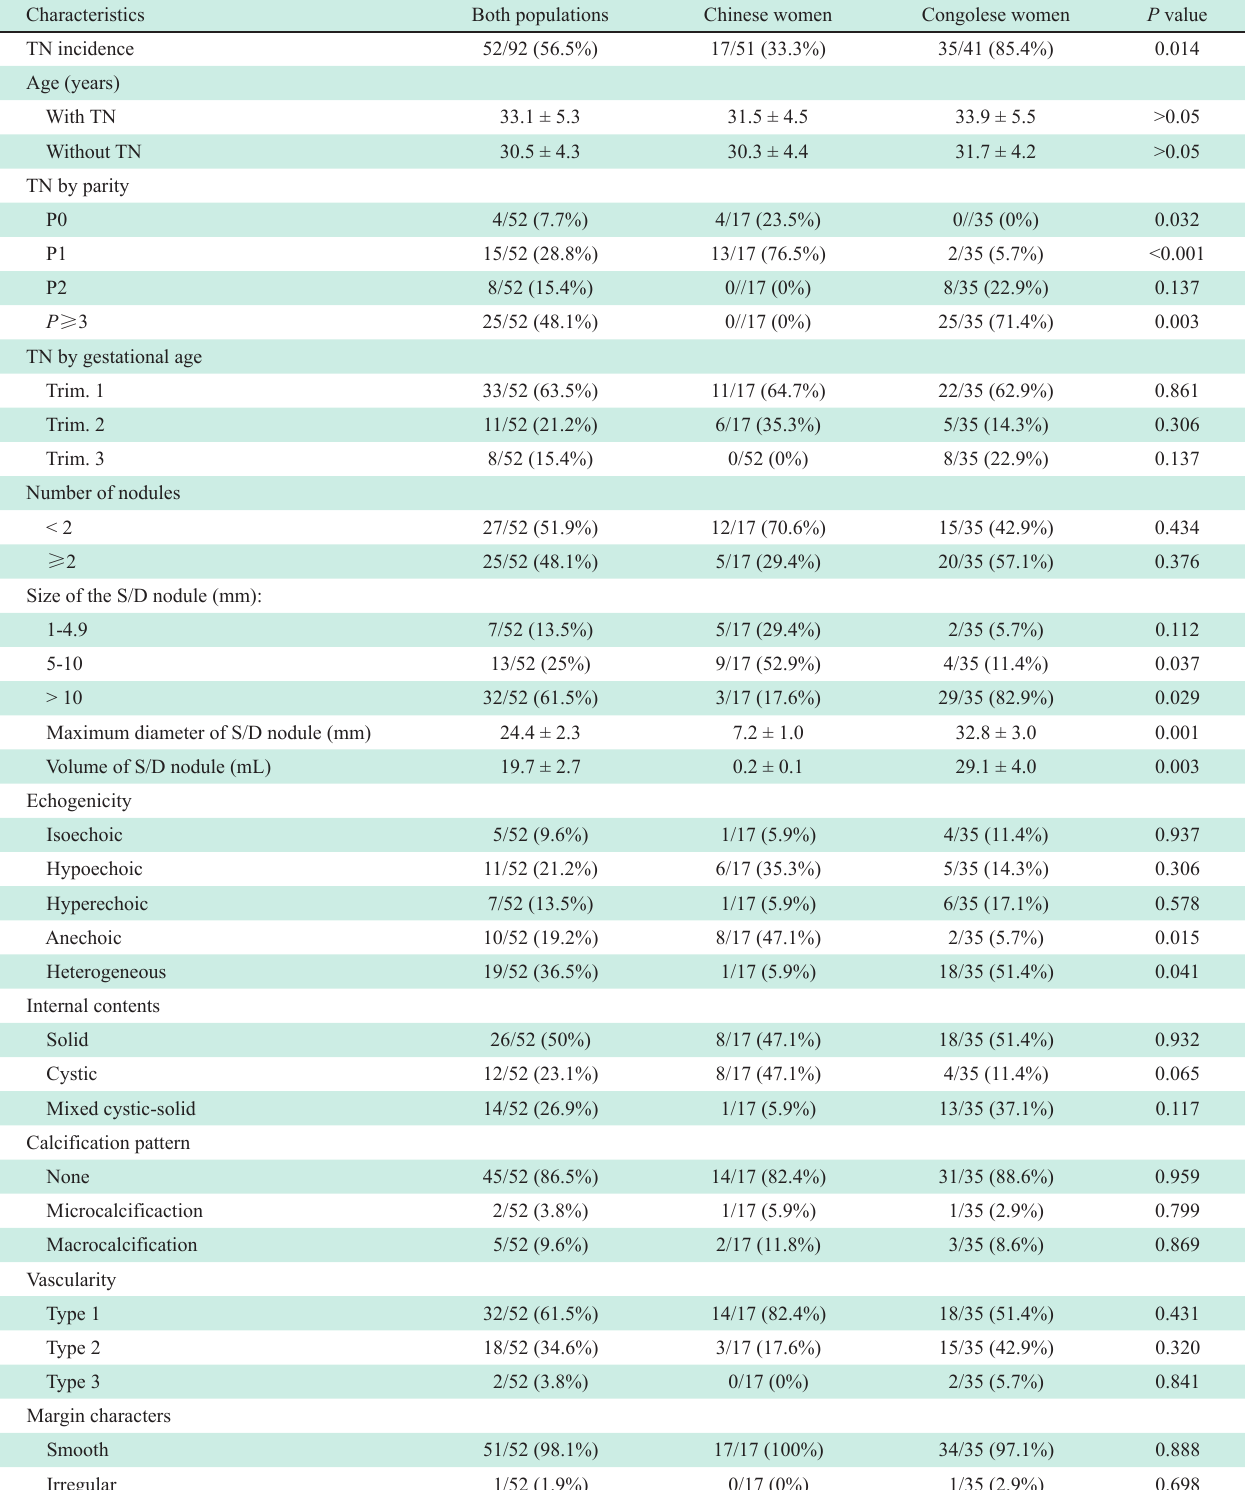
Table 2 Ultrasound characteristics of the thyroid nodules and epidemio-clinical distribution of women